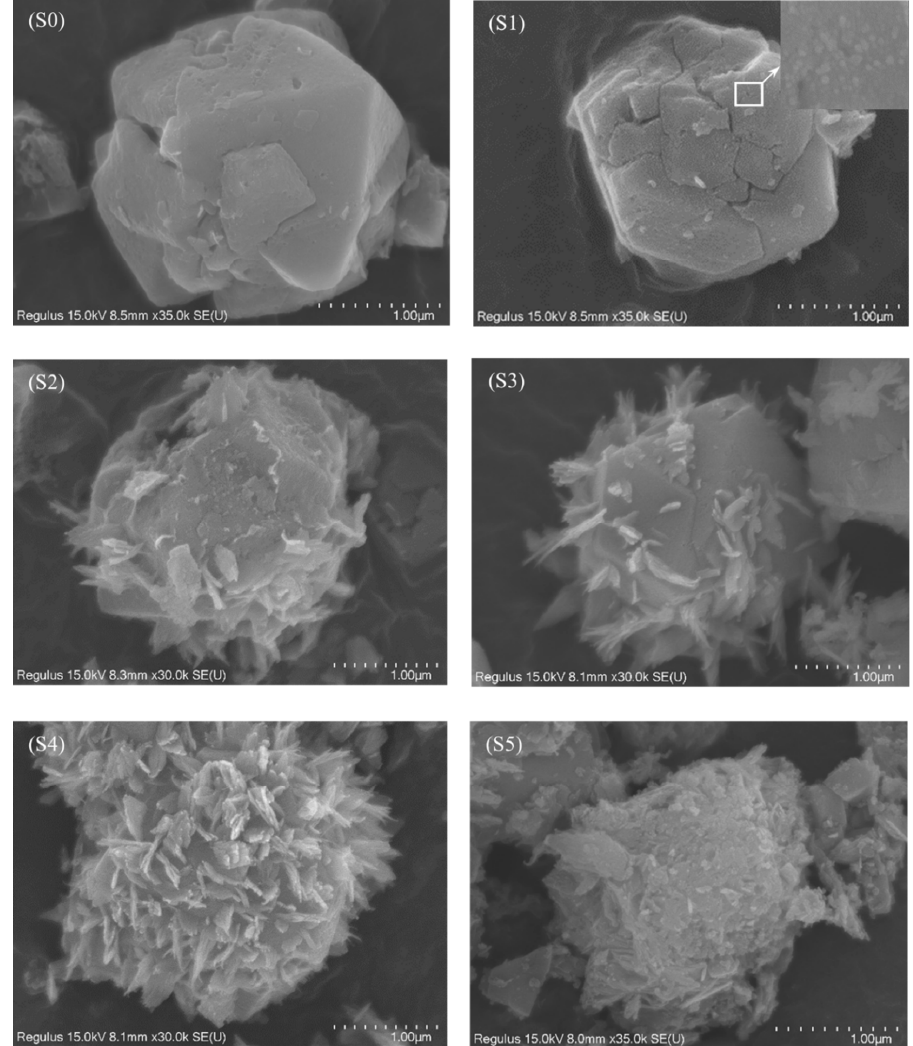
Figure 2. SEM images of samples: (S0) zeolite 10X; (S1–S5) CuO-zeolite NCs. The XPS analysis of zeolite 10X and CuO-zeolite NCs are shown in Figure 3a,b. The survey spectrum in Figure 3a indicates that zeolite 10X (S0) was mainly composed of Si, Al, Ca, and O, and CuO-zeolite NCs (S2, S4) contained mostly Cu, Si, Al, and O. The increase in Cu ion concentration resulted in the emergence of Cu peaks, while the intensity of the Ca peak declined, indicating the replacement of Ca ions by Cu ions. The high- resolution XPS spectrum of Cu 2p is shown in Figure 3b. The Cu 2p 3/2 and Cu 2p 1/2 peaks centered at 934.1 eV and 953.8 eV, respectively, and were attributed to Cu(II) [22,26]. The presence of only Cu(II) was verified by XPS.